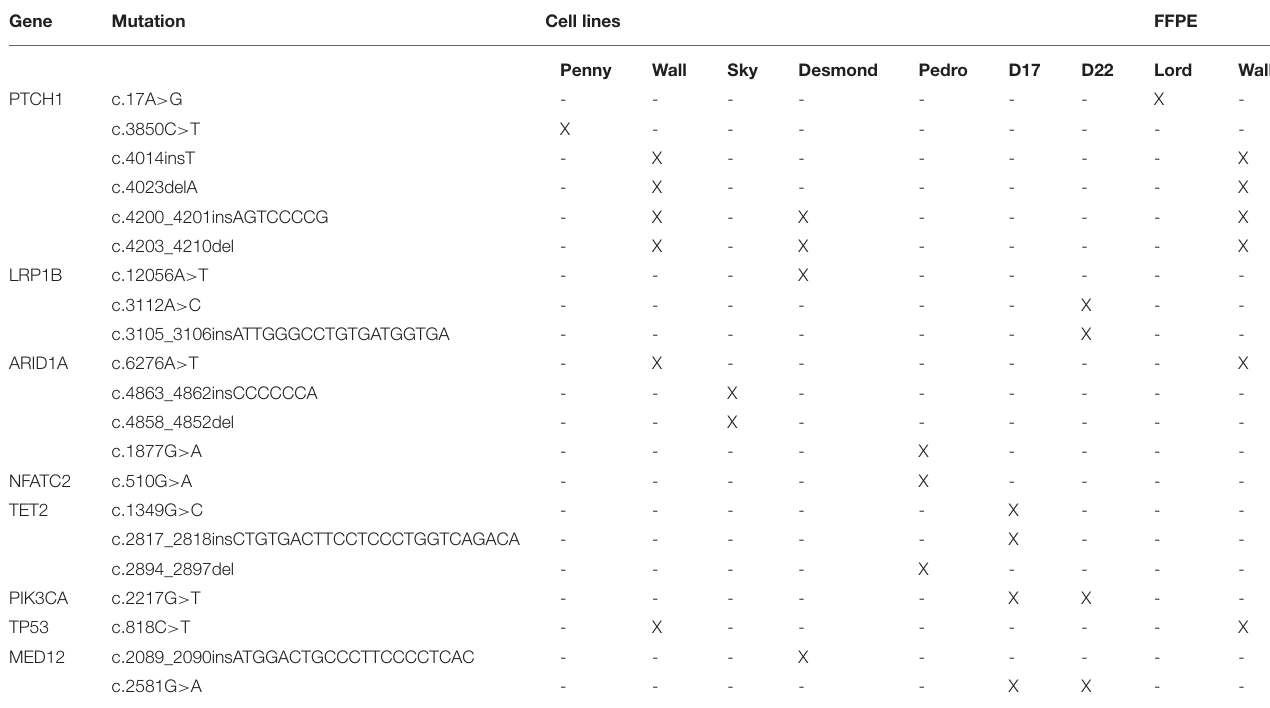
TABLE 1 | List of putative driver genes and variants across all the cell lines. Gene